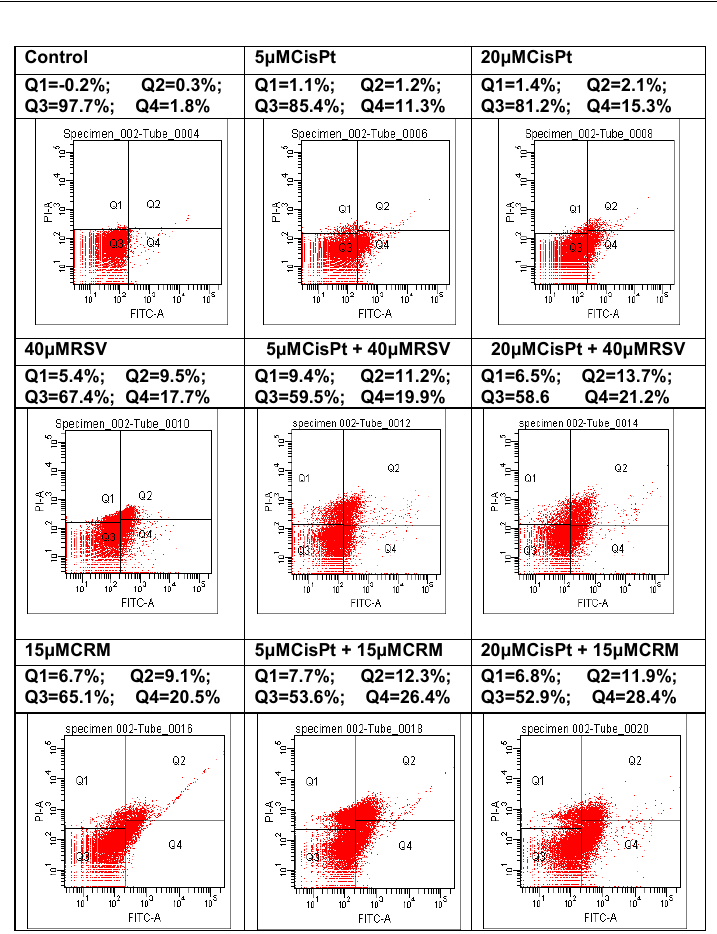
Figure 7. Natural compounds (RSV or CRM) effects on the apoptotic process of PE/CA-PJ49 tumor cells treated 24 h with CisPt and/or RSV or CRM (Dot-plot analysis).